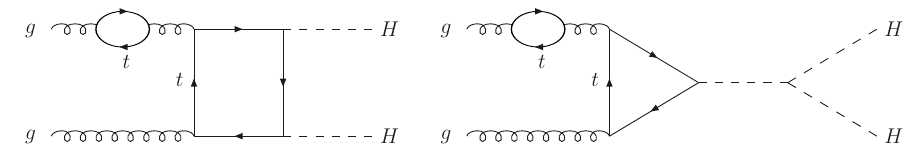
Figure 7 . Typical diagrams with external top